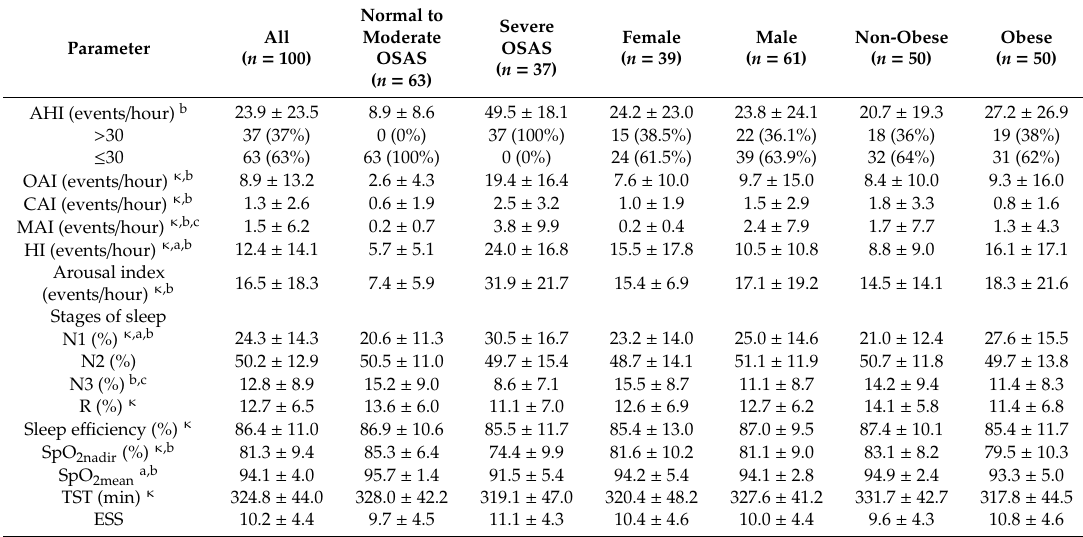
Table 2. Polysomnography findings of all participants.